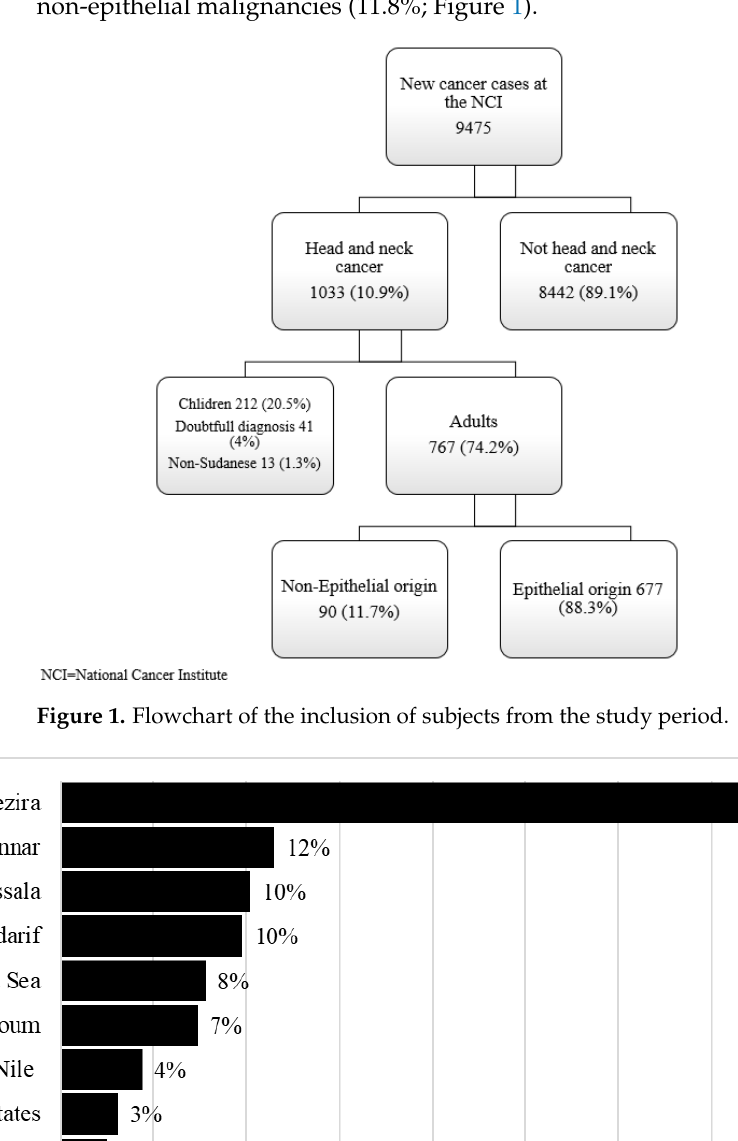
Figure 3. Proportions of HNCs out of all cancer cases from September 2016 to September 2020.